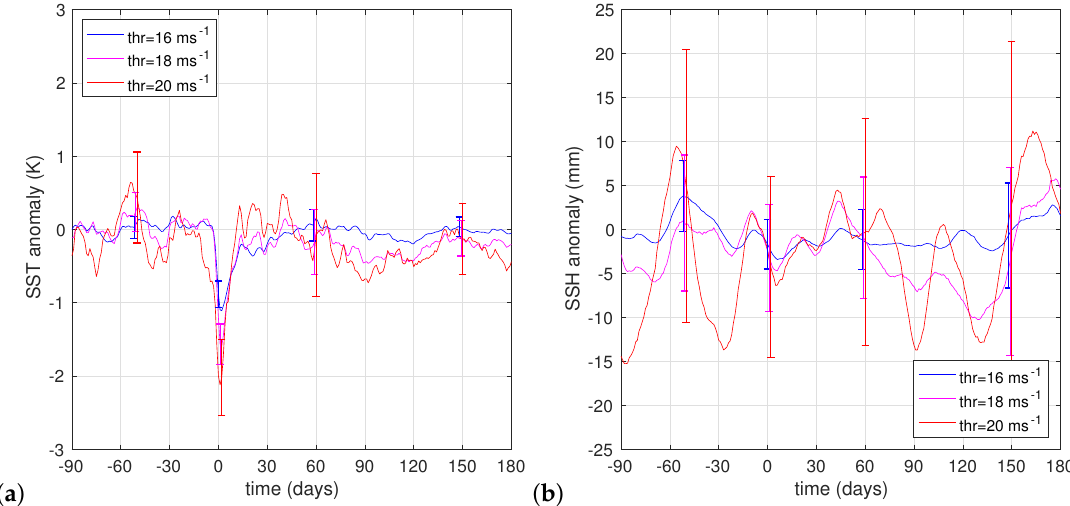
Figure 4. Composite average of time evolution before and after the intense wind events for SSTA ( a ) and SSHA ( b ) during the summer season, for wind speed thresholds of 16 (blue), 18 (magenta) and 20 (red) ms − 1 . Error bars at − 50, 5, 60, and 120 days are computed as 2 standard deviations of the composite